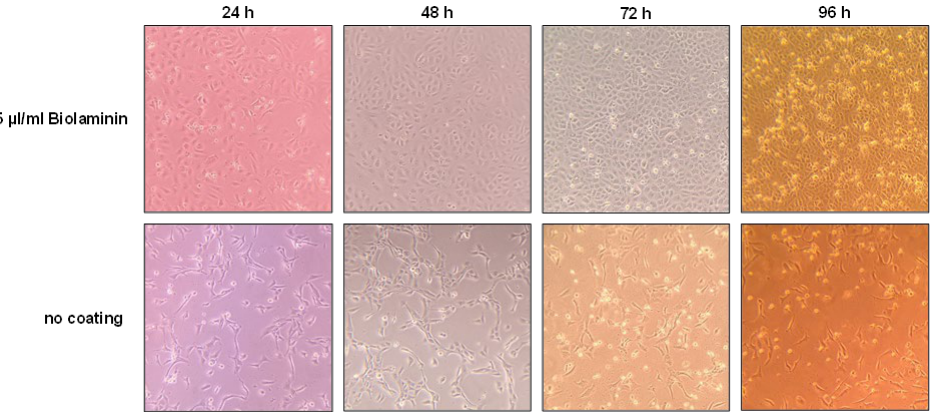
Figure 1. Establishing Vero-E6 cell culture conditions in the CliniMACS Prodigy CentriCult™ Units (CCU) were either coated with 30 mL 5 µg/mL Biolaminin in PBS or 30 mL PBS for 3 h at 37 °C. Subsequently, 4.5 × 10 6 freshly thawed Vero-E6 cells were added to each CCU and incubated at 37 °C for 4 days. A picture was taken every 24 h, followed by a media change to 30 mL fresh glutamine-supplemented OptiPRO.